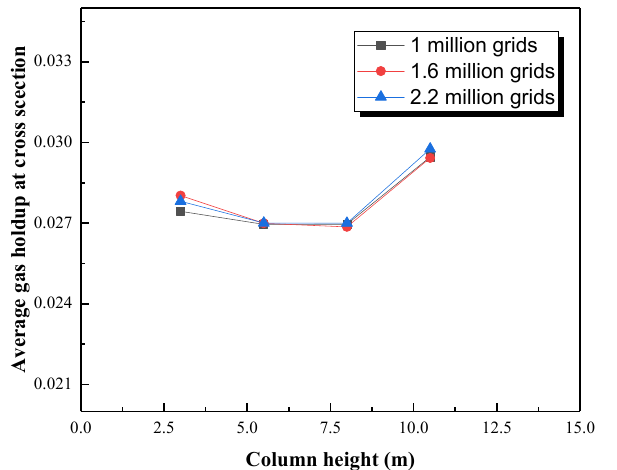
Figure 3. Variation of average gas holdup at the cross section with different grid numbers.